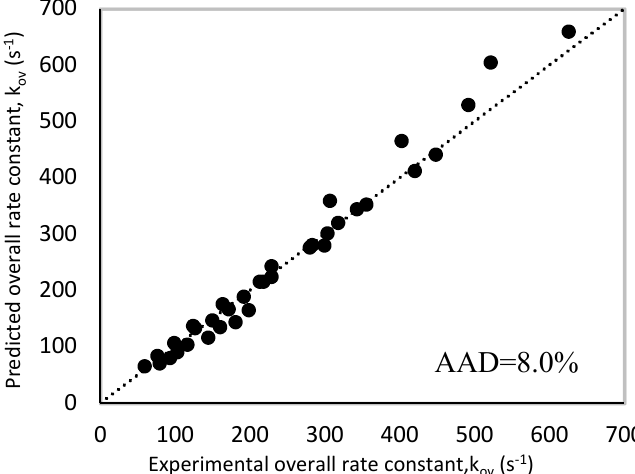
Figure 11. Parity plot of experimental and predicted ‘k Arg ’ values for termolecular mechanism. Table 9. Summarized kinetics rate constants for CO 2 -MDEA-Arg reaction using Termolecular Mechanism.